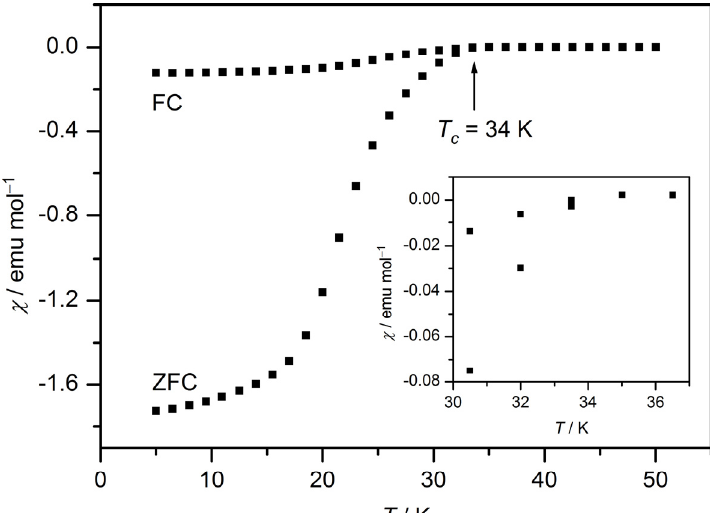
Figure 6. Magnetic susceptibility of polycrystalline Ca samples in a magnetic field of 100 Oe with a close-up of the transition